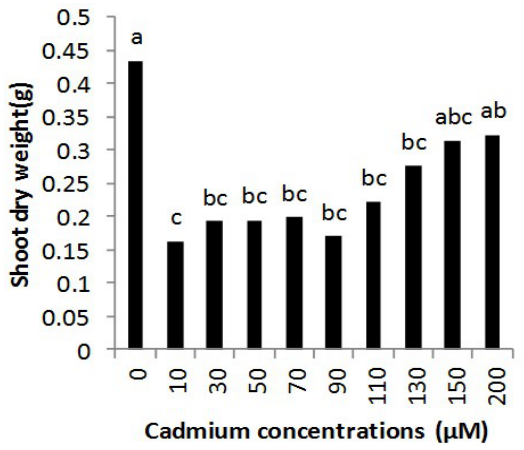
Fig. 5 . Effects of cadmium on shoot dry weight of Brassica napus L.